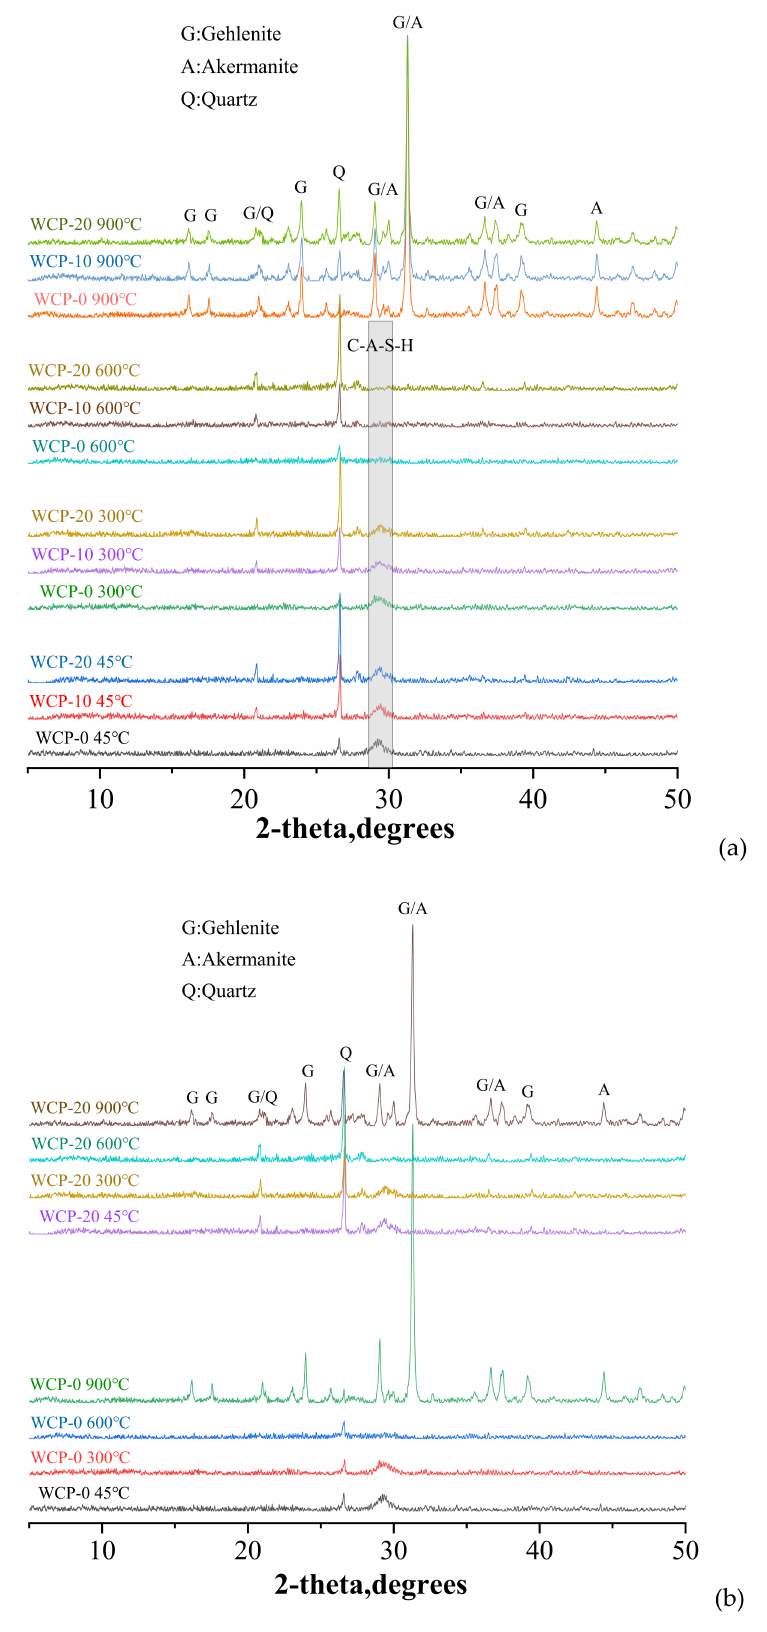
Figure 9. ( a ) XRD patterns of all the samples before and after heating. ( b ) XRD patterns of WCP-0 and WCP-20 before and after